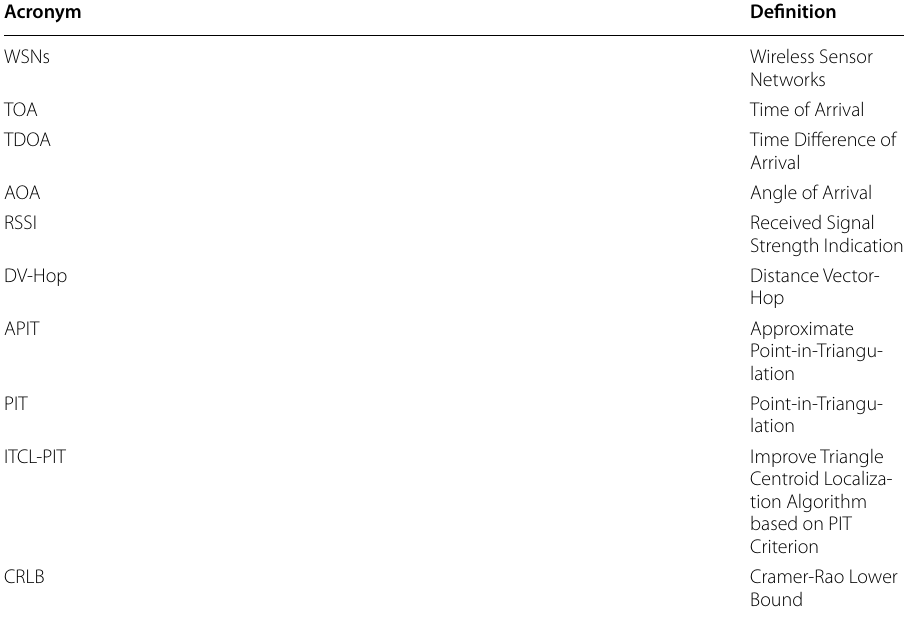
Table 1 Summary of important